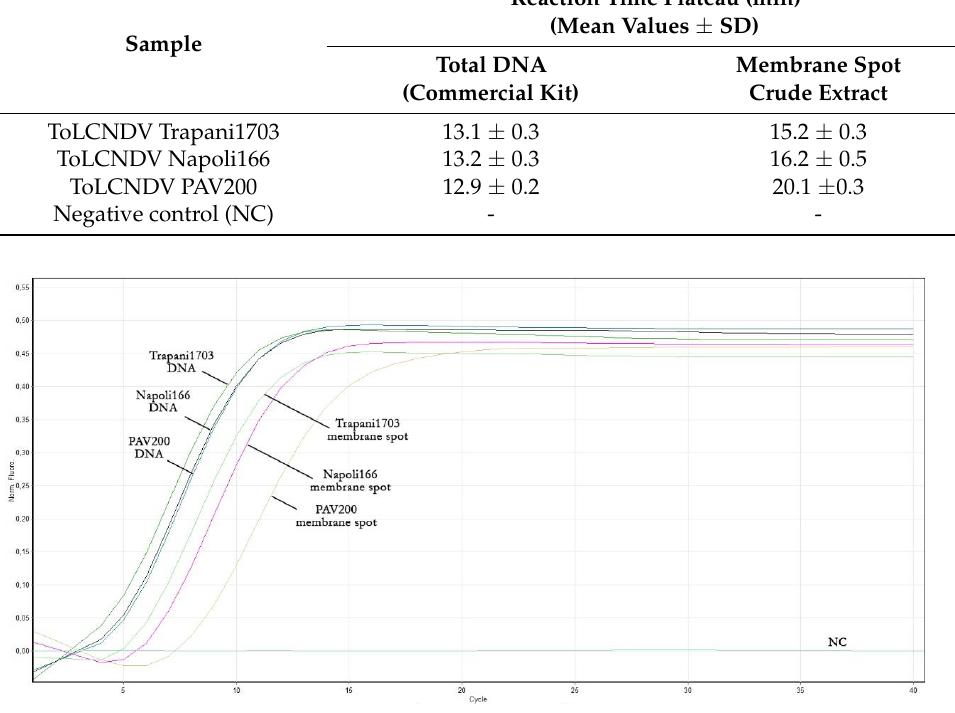
Figure 4. Real-time LAMP amplification curves of the three ToLCNDV isolates starting from total DNA obtained with a commercial kit and the membrane spot crude extract method.